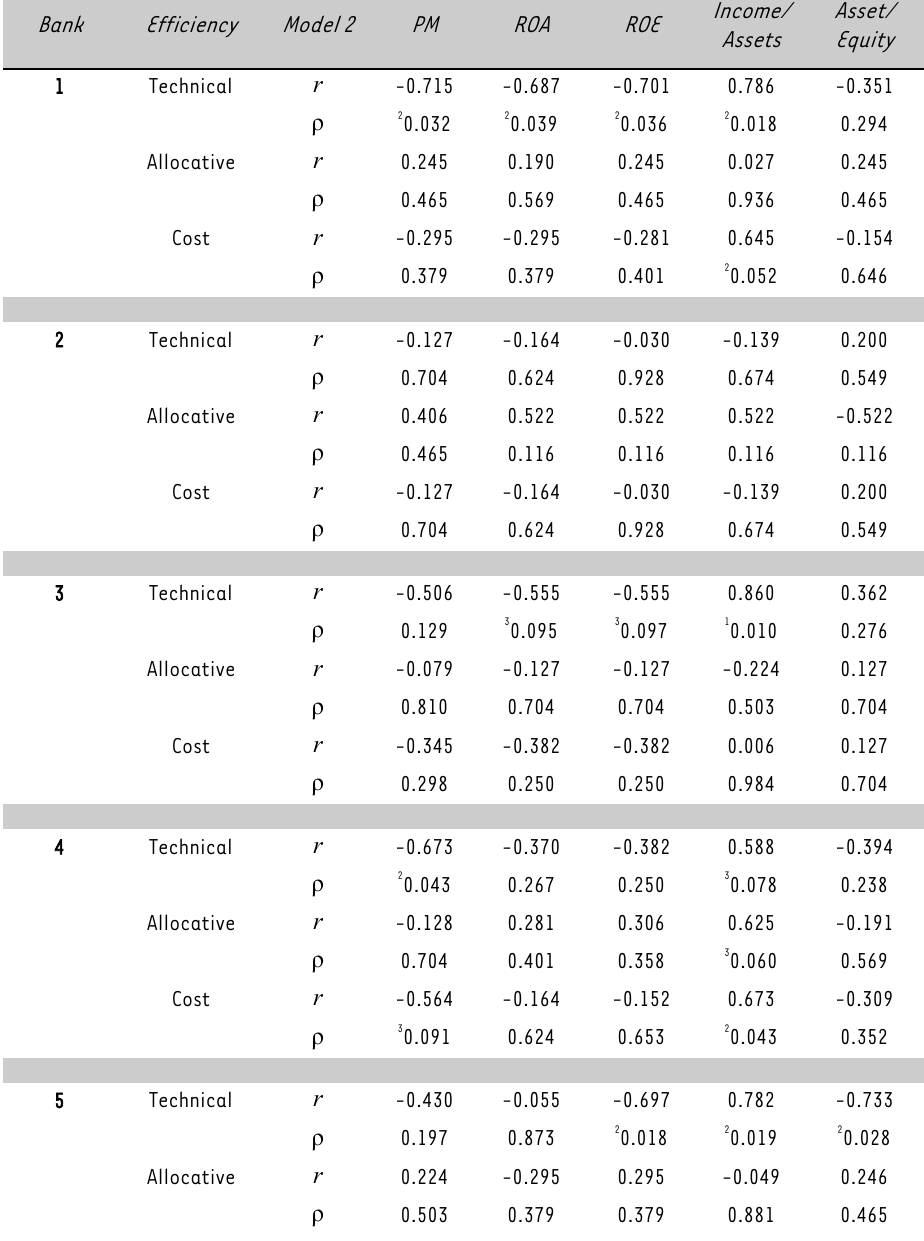
TABLE 3: Correlation coefficient ( r ) between DEA estimates in Model 2 and financial ratio analysis, and testing of the hypothesis ( ρ